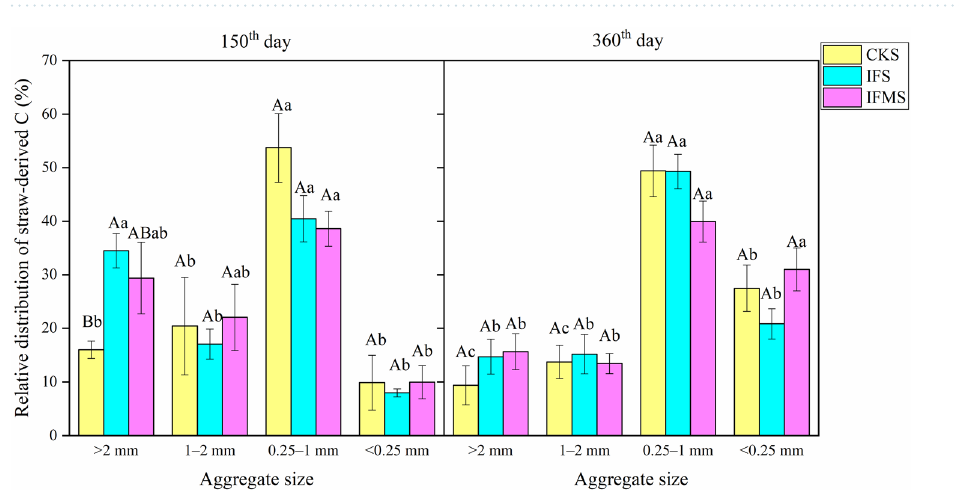
Figure 4. The relative distribution of straw-derived C in soil aggregates (%). Note : Treatments including CKS (no fertilization control + straw), IFS (inorganic fertilizer + straw), IFMS (inorganic fertilizer plus manure + straw). Vertical bars represent the standard error of the mean significant variations (SEM; n = 3). Values followed by different letters (uppercase among various fertilizer management strategies and lowercase letters among various aggregate sizes) mean significant variations ( P < 0.05) in the relative distribution of straw- derived C in soil aggregates